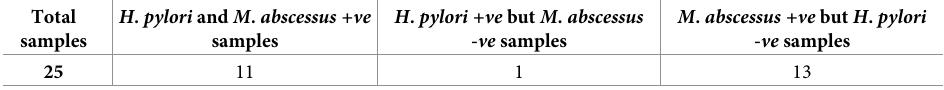
Table 5. Prevalence of M . abscessus and H . pylori among patients with severe gastric diseases. Total samples